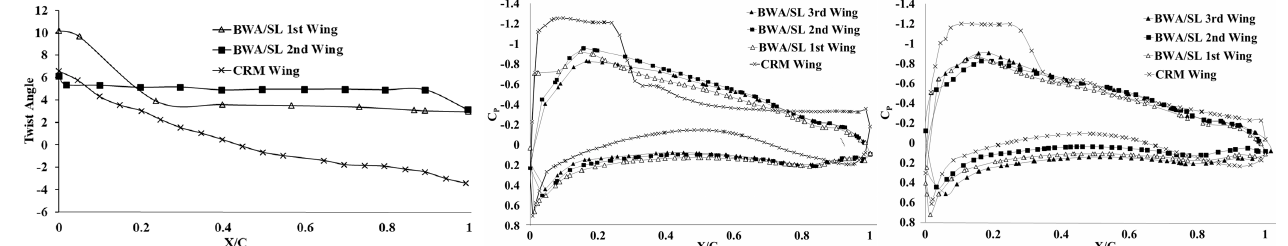
Figure 21. Twist of the BWA/SL backward-swept wings, with comparison with that of CRM ( left ). Wall pressure distribution around the wings at 70% ( center ) and 90% ( right ) of their span, as obtained for BWA/SL and CRM aircraft in their cruise flight condition S 3 (M = 0.7 at 43,000 ft) with an angle-of-attack α = 0° and S 1 (M = 0.85 at 44,000 ft) with an angle-of-attack α = 2°, respectively. As a result, whereas the wall pressure distribution evolves along the CRM wingspan, it remains almost unchanged along each of the BWA/SL wings. This may explain why the aerodynamic performance of BWA/SL aircraft is more “conservative” than that of its CRM